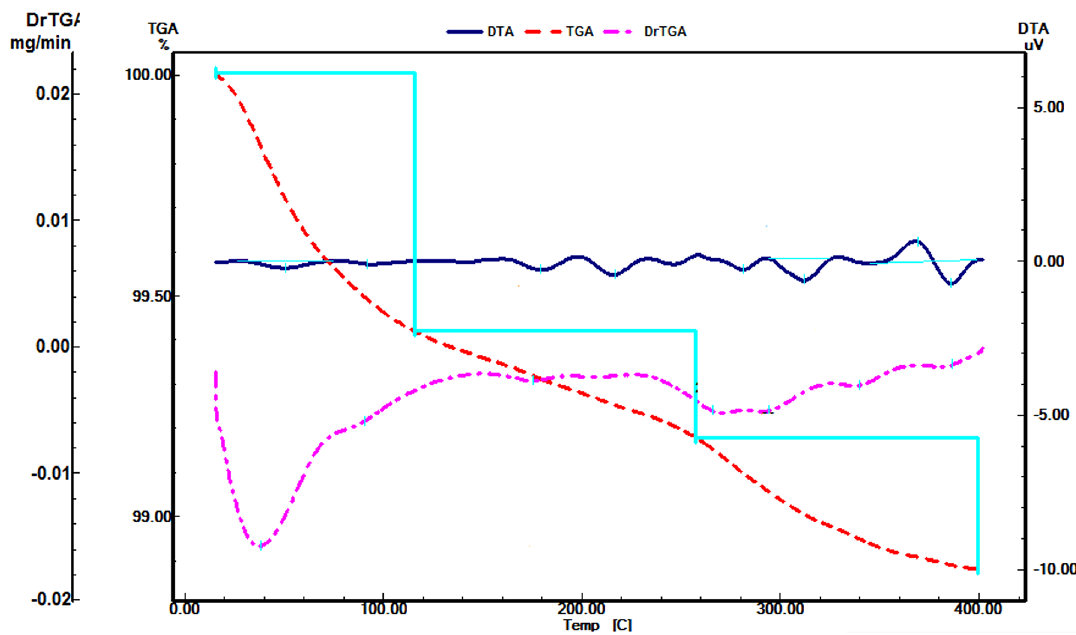
Figure 7. TG/DTG/DTA of as-synthesized In